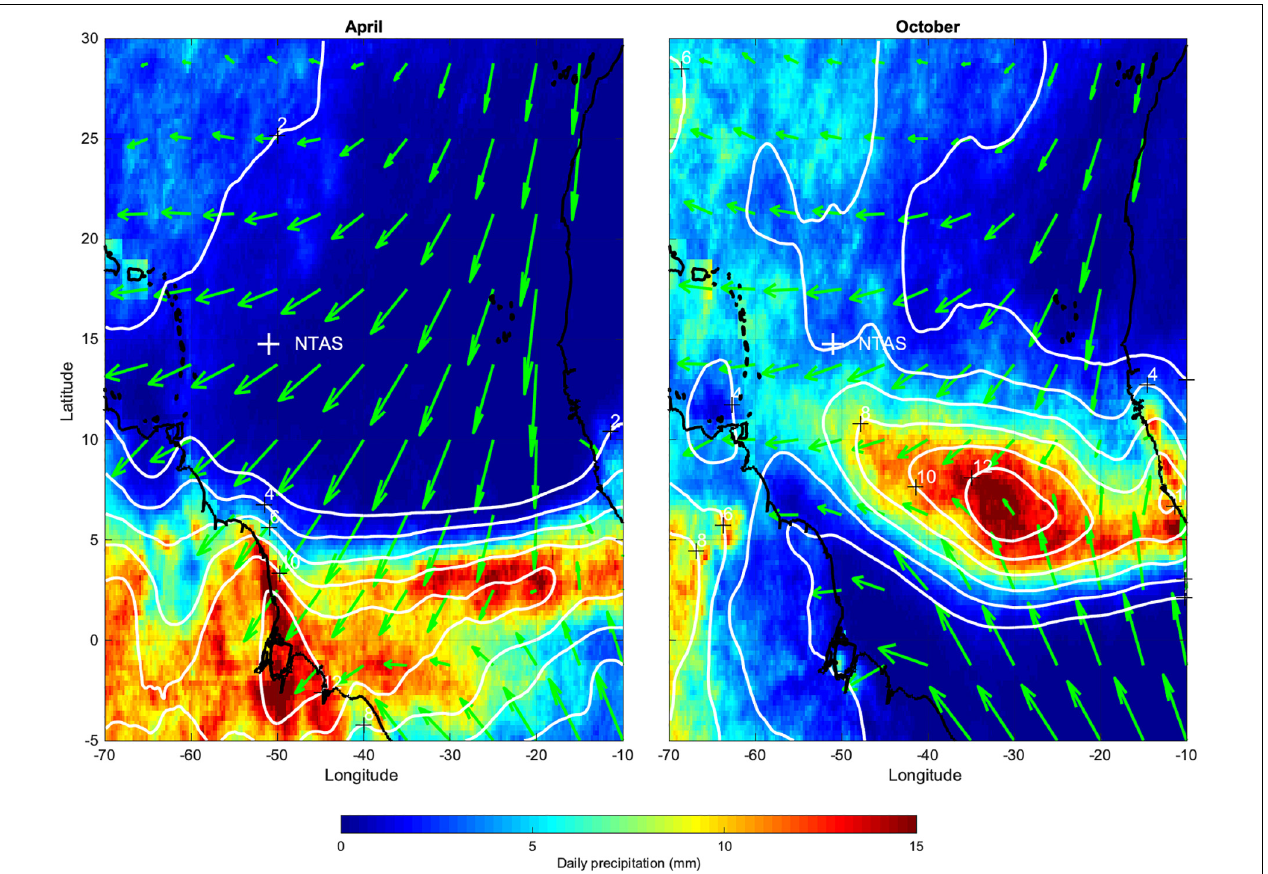
FIGURE 1 | Tropical Rainfall Measuring Mission daily precipitation accumulation (mm) in color shading and white isolines every 2 mm (label locations denoted by black crosses): averages for April (left) and October (right) during period 2002 to 2011. Green arrows are 10-m wind vectors, averages for same months, using Seawinds data from 2000 to 2012. White cross indicates the NTAS buoy location near 51 ◦ W, 15 ◦ N. Coastlines in black